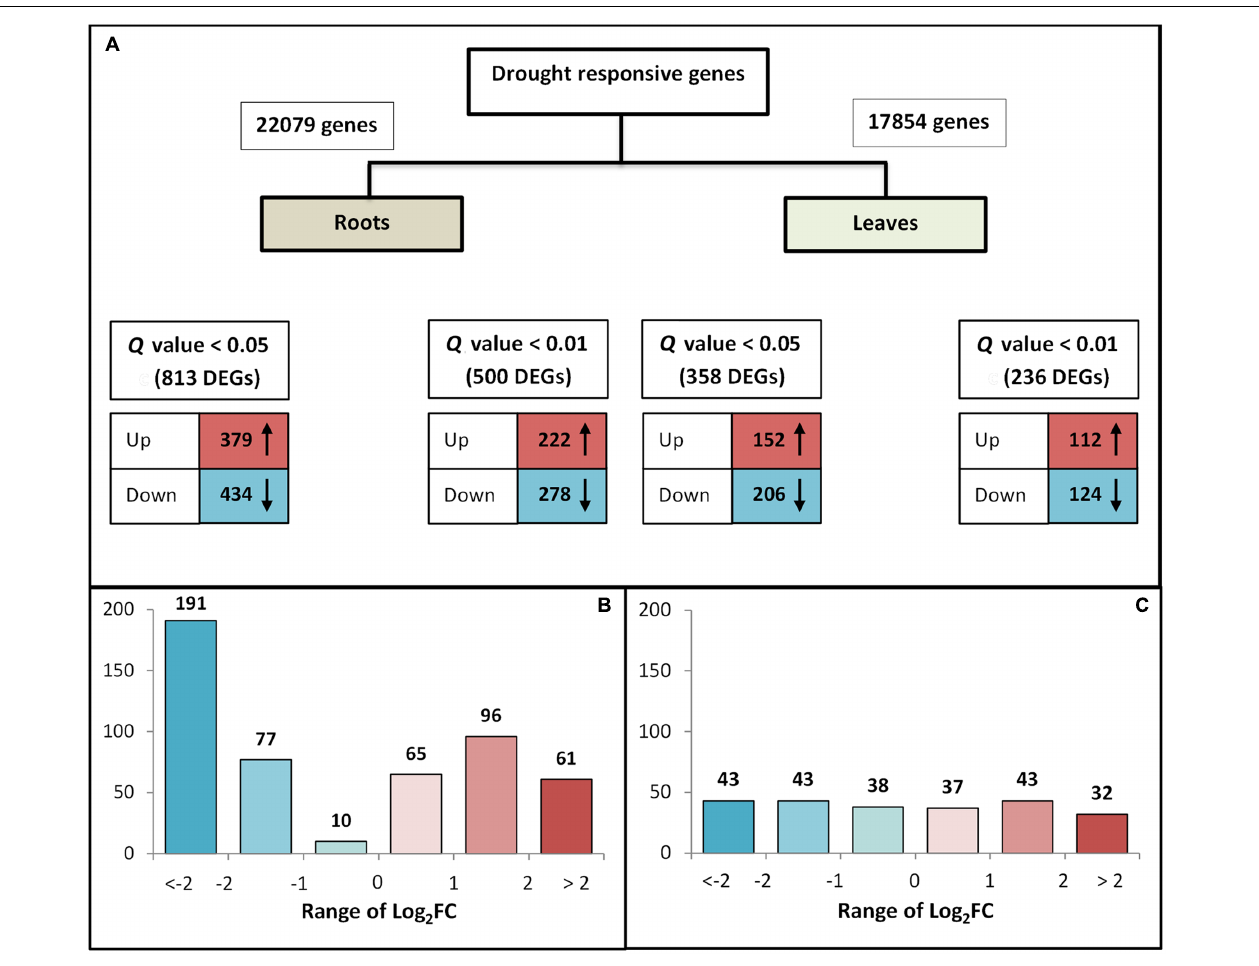
FIGURE 2 | (A) Number of total and differentially expressed genes (DEGs) showing either upregulation or downregulation at different Q -values in roots (GF677 rootstock) and leaves (graft, var. Catherina). Up: upregulated genes (red); down: downregulated genes (blue). (B,C) Relative expression of DEGs selected at Q -value < 0.01 in roots and leaves. The color intensity indicates the level of the change in expression: a darker color represents a larger change in expression. The x -axis indicates the range of Log 2 FC. The fold change (FC) was calculated as the ratio between the drought-stressed and control plants, while the y -axis indicates the number of detected